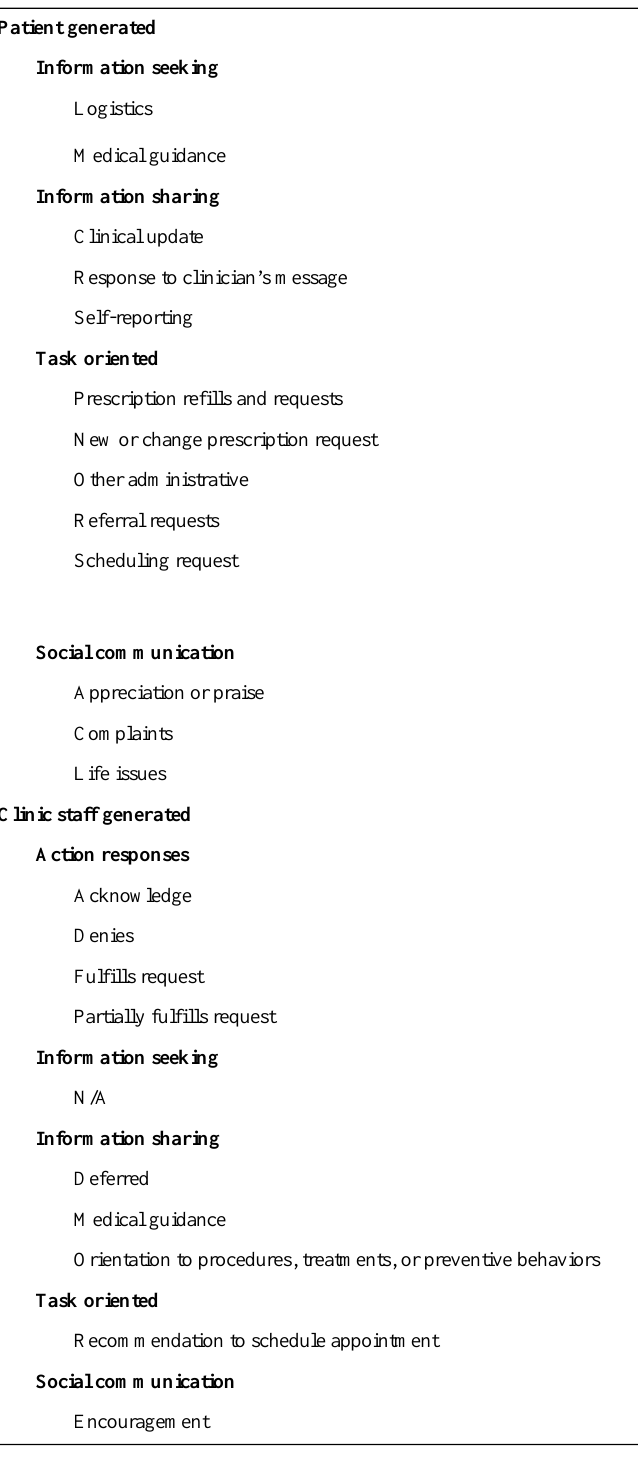
Level 3 taxonPatient or clinician generated taxon, Level 1, and Level 2